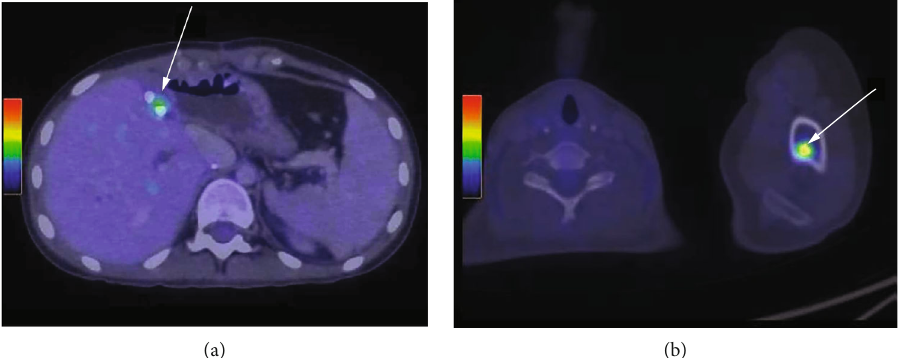
Figure 8: Postoperatory PET scan images. (a) No evidence of disease in the liver (arrow is showing an encapsulated fl uid collection). (b) Blastic bone lesion at the left humerus